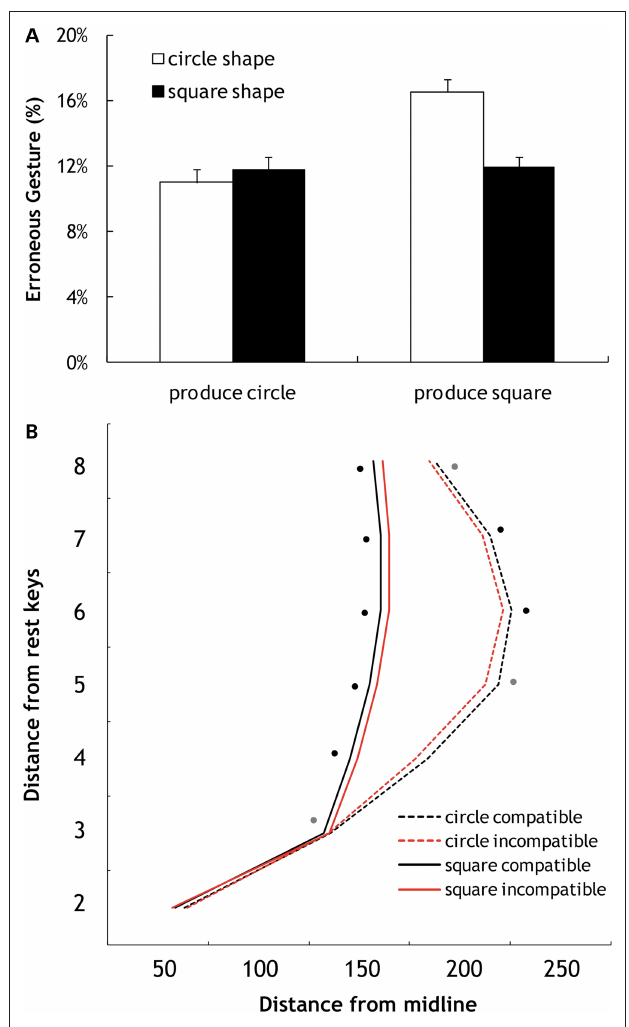
Figure 6 | (A) Represents the percentage of erroneous trials detected by the correlation procedure. Error bars show the standard error of the mean. (B) Shows the trajectories for circles and squares in the compatible and incompatible trials. Dots next to the trajectories mark significant differences in pairwise two-sided t -tests (gray, p < 0.10, black; p < 0.05) between the compatible and incompatible conditions for circles and squares for each of the y